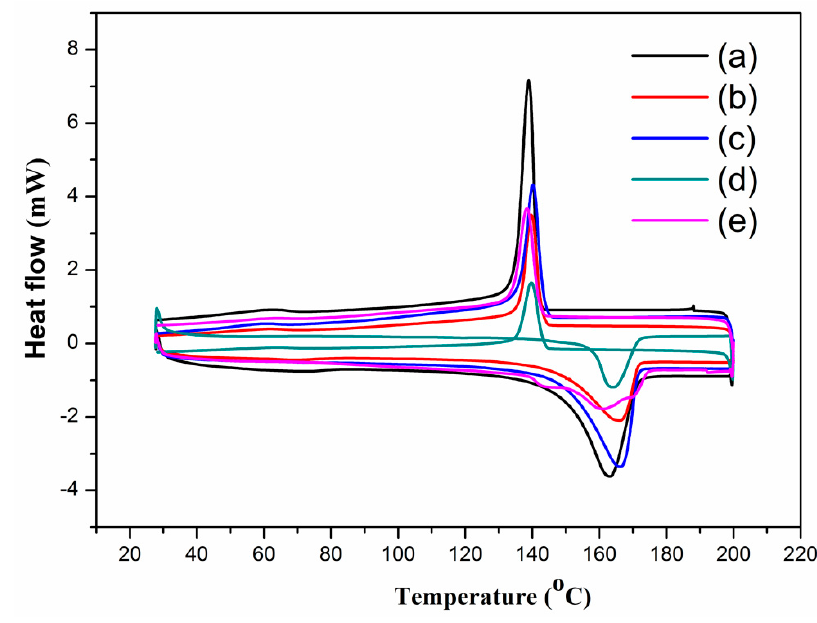
Figure 2. DSC thermograms of PVDF/MWNTs composites with ( a ) pure PVDF; ( b ) 7 wt.% MWNTs, ( c ) 15 wt.% MWNTs; ( d ) 25 wt.% MWNTs and ( e ) 35 wt.% MWNTs. ( c ) 15 wt.% MWNTs; ( d ) 25 wt.% MWNTs and ( e ) 35 wt.% MWNTs. Table 1. Area of the melting peak of the PVDF/MWNTs composites. Table 1. Area of the melting peak of the PVDF/MWNTs